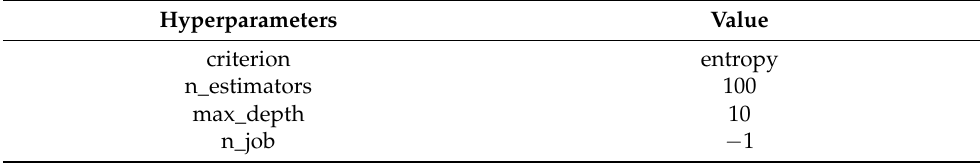
Table 5. Final RF